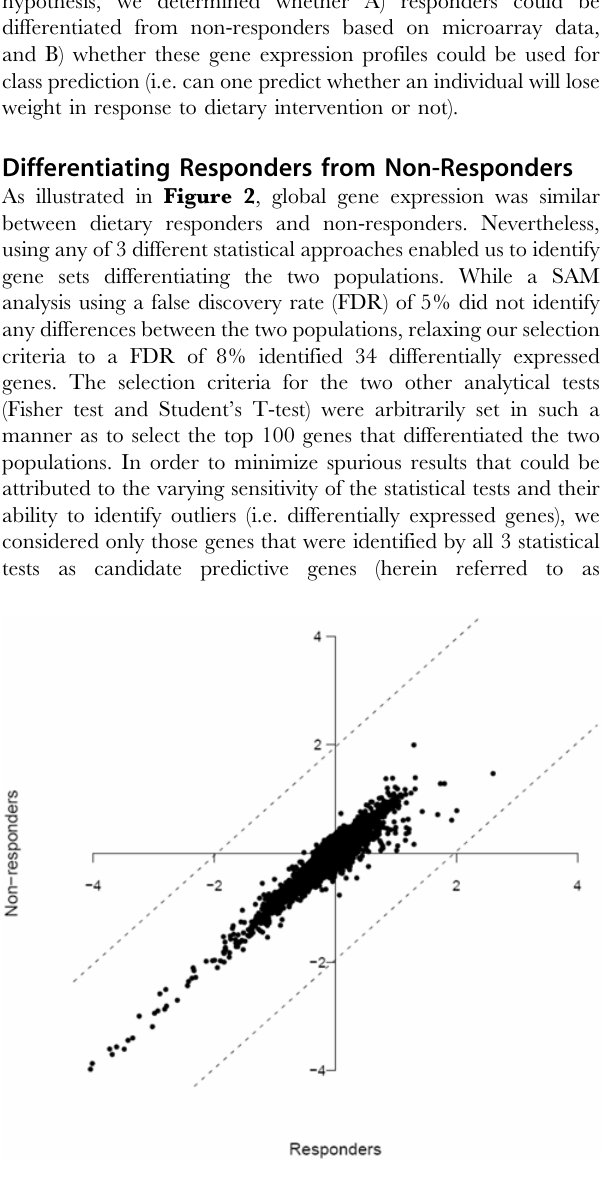
Figure 2. Distribution of the mean gene expression levels in responders and non-responders, computed from microarray mea- surements normalized with respect to the standard Gaussian distribution. Each spot represents the mean expression for a single gene. Dotted lines indicate the 95% confidence interval of the means (equal to 1.96 * standard deviation).